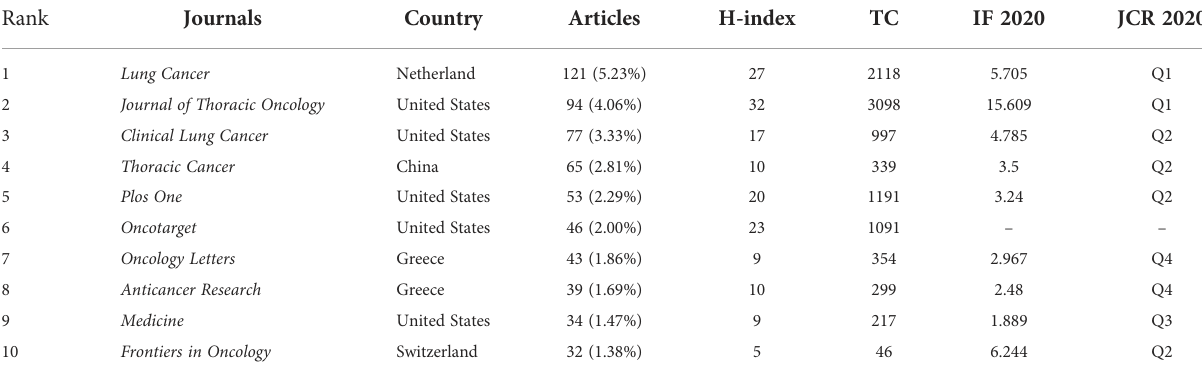
TABLE 3 The top 10 productive journals related to